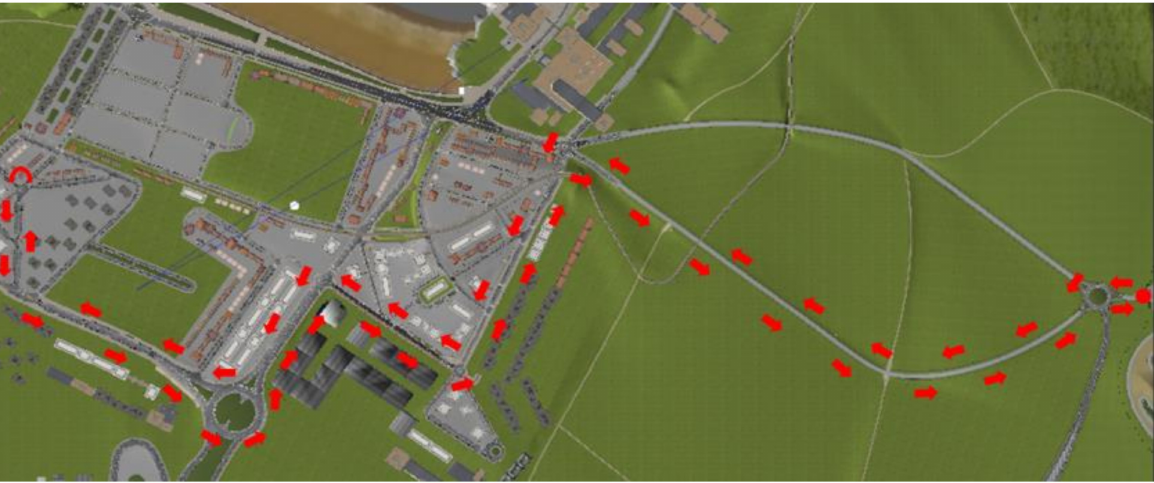
Figure 3. The trajectory of the